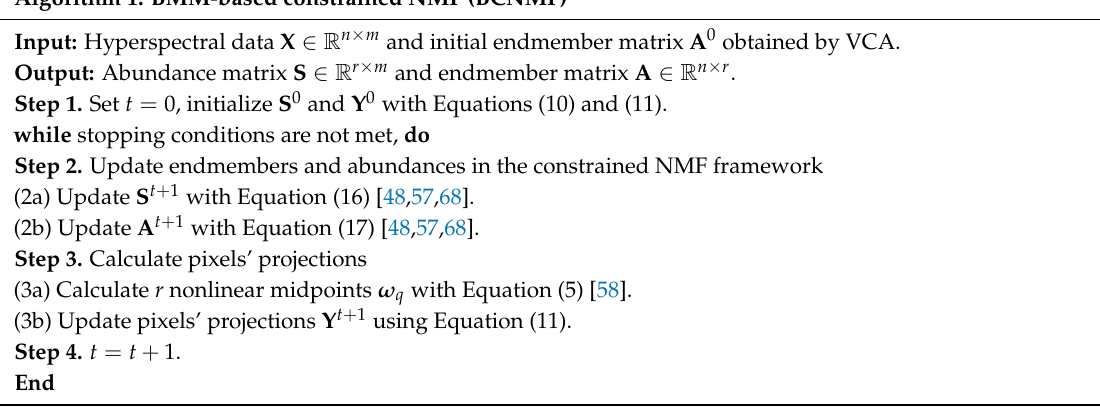
Algorithm 1: BMM-based constrained NMF